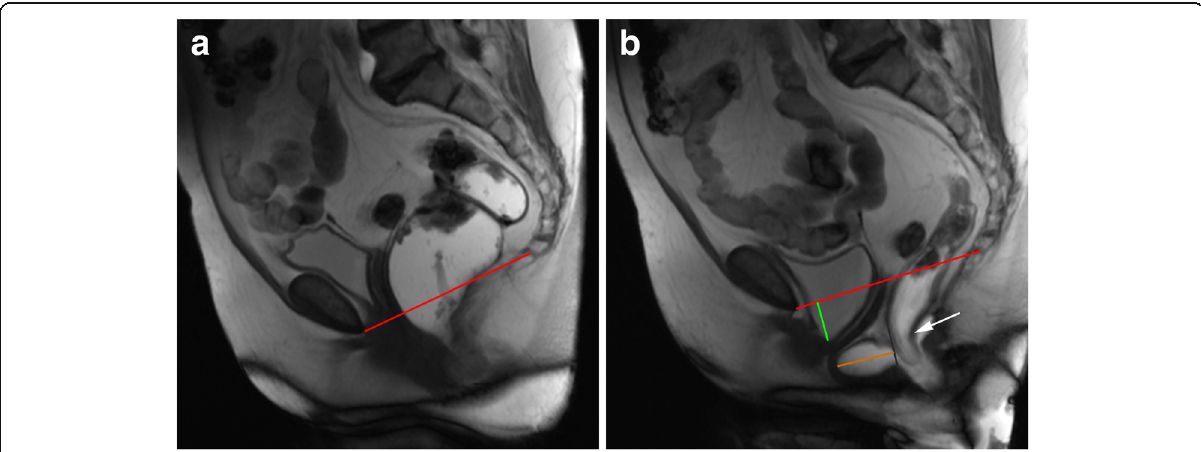
Fig. 13 Moderate anterior rectocele. ( a , b ) Sagittal midline TrueFISP images at rest ( a ) and during evacuation ( b ) revealing a moderate anterior rectocele (orange line: 37 mm). Note also a cystocele (green line) and a rectal intra-anal intussusception (white arrow). Red line : PCL line; black line : normal expected contour of the anterior anorectal wall